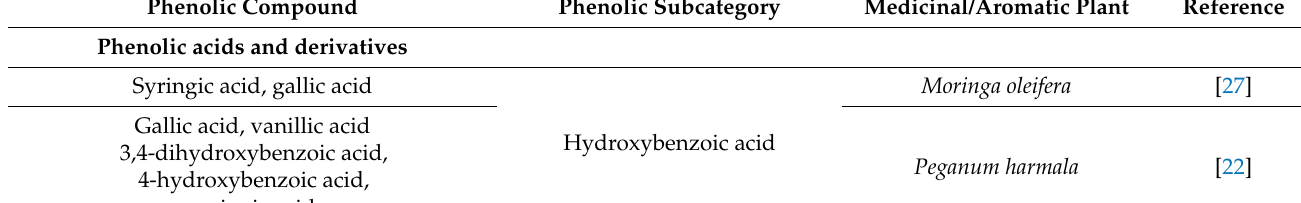
Table 1. Compounds identified from selected medicinal and aromatic plants for the different phenolic